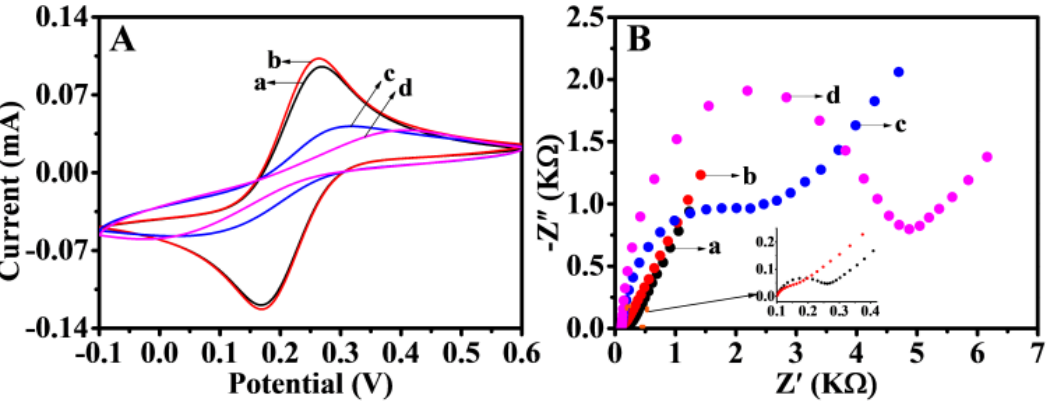
Figure 5. CV ( A ) and EIS ( B ) at bare GCE (a) and Au/NiFe-LDH/GCE (b). P1/Au/NiFe-LDH/GCE (c) and MCH/P1/Au/NiFe-LDH/GCE (d) in 5 mM of K 3 [Fe(CN) 6 ] containing 0.1 M KCl.